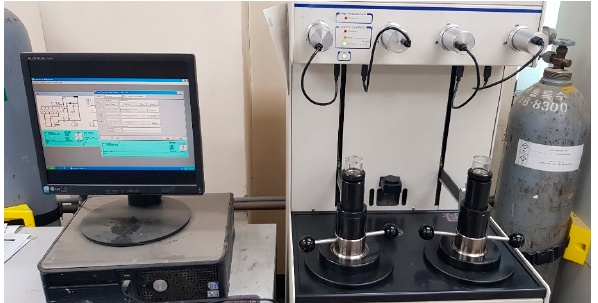
Figure 5. Mercury intrusion porosimetry test set-up .